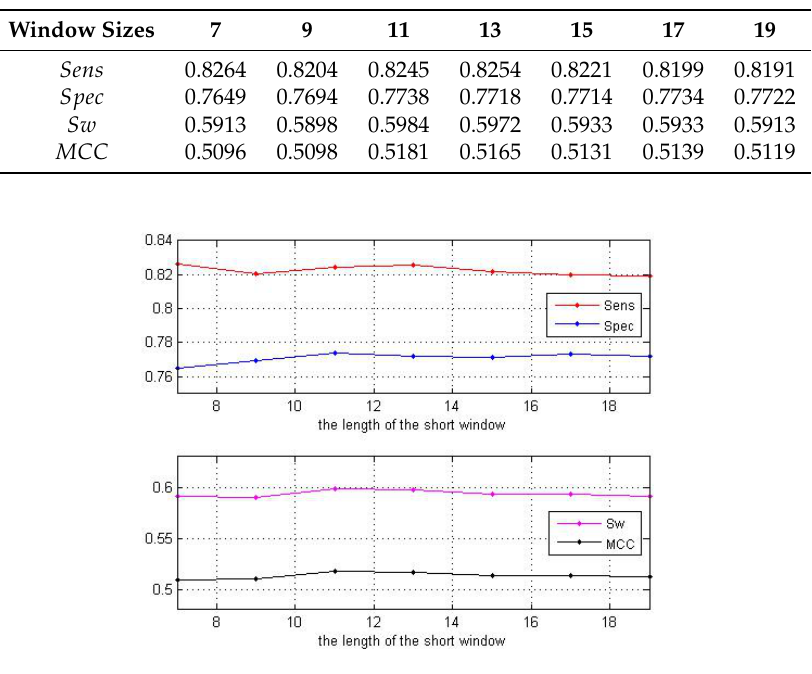
Figure 4. Performance with different short